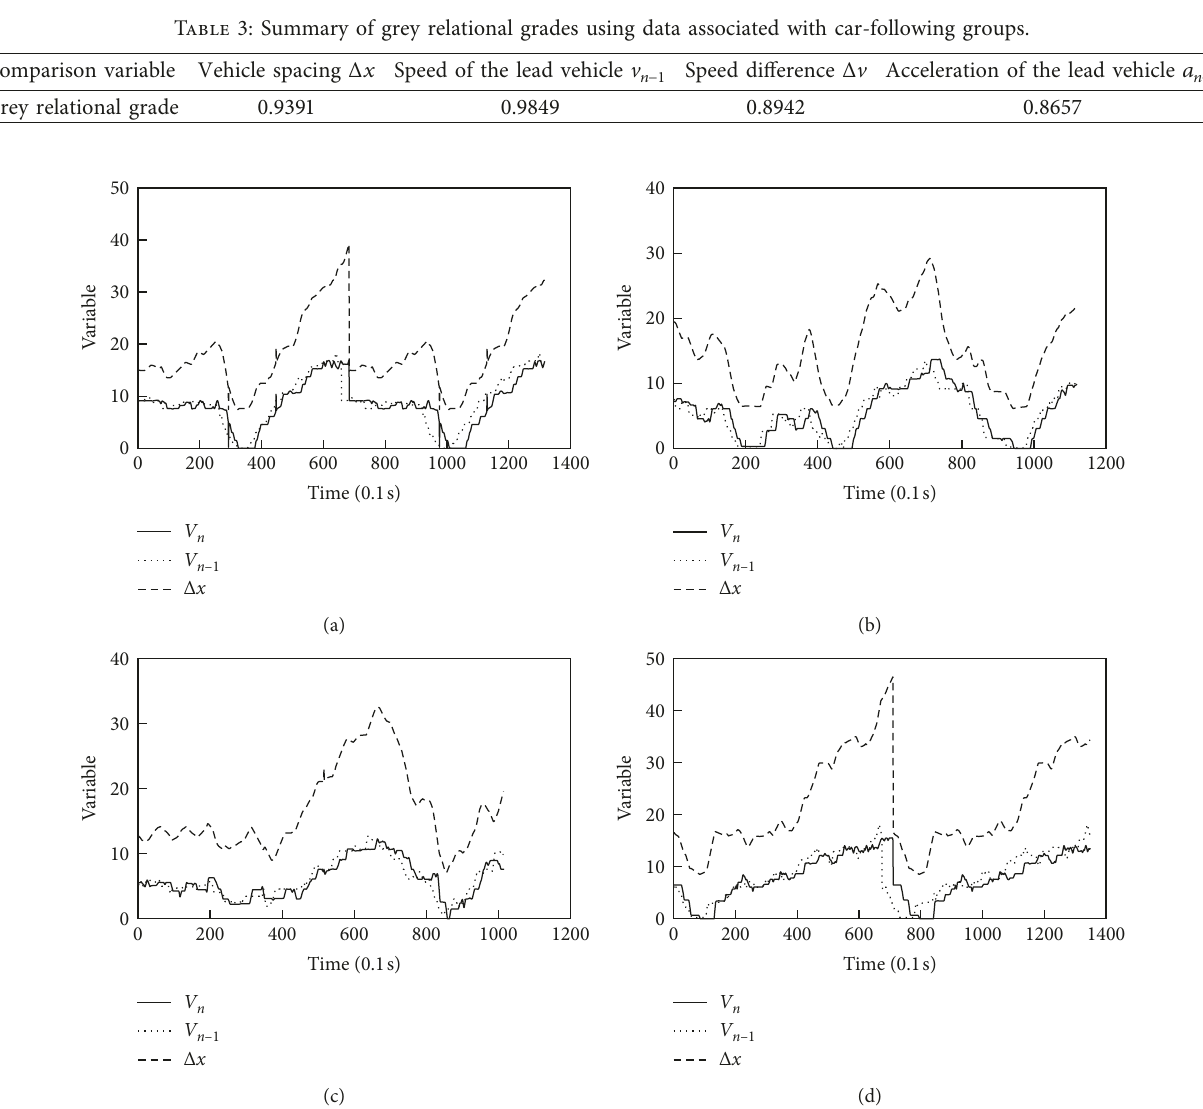
Figure 2: An example of time-varying correlations of speed of the lag vehicle with car-following spacing and speed of the lead vehicle. (a) Line 1, (b) line 2, (c) line 3, and (d) line